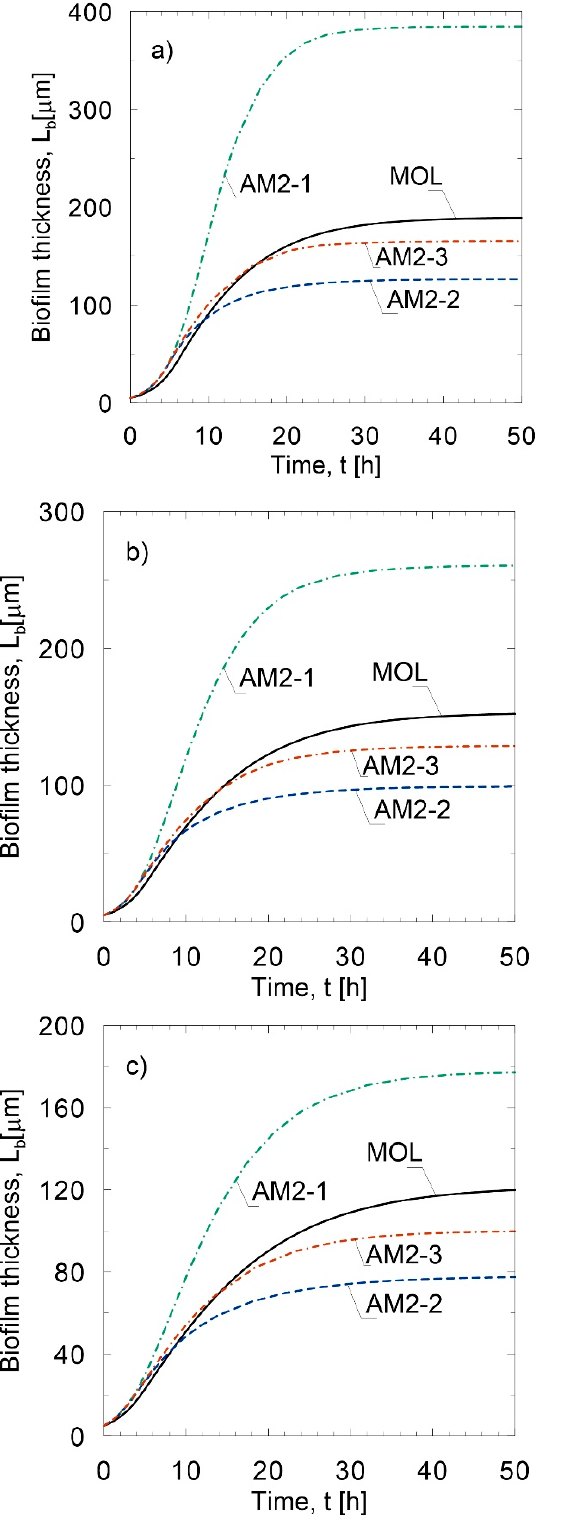
Figure 6. Illustration of the accuracy of the approximate model family AM2; left ( a – c )—glucose utilization; right ( d – f )—phenol degradation; top— c c utilization; “ 0.01 kg { m 3 bottom— c c A